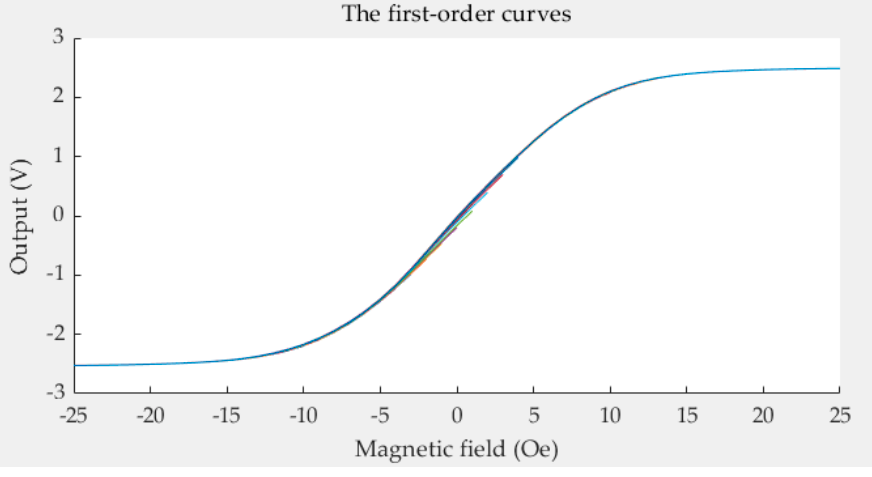
Figure 7. The first-order curves.